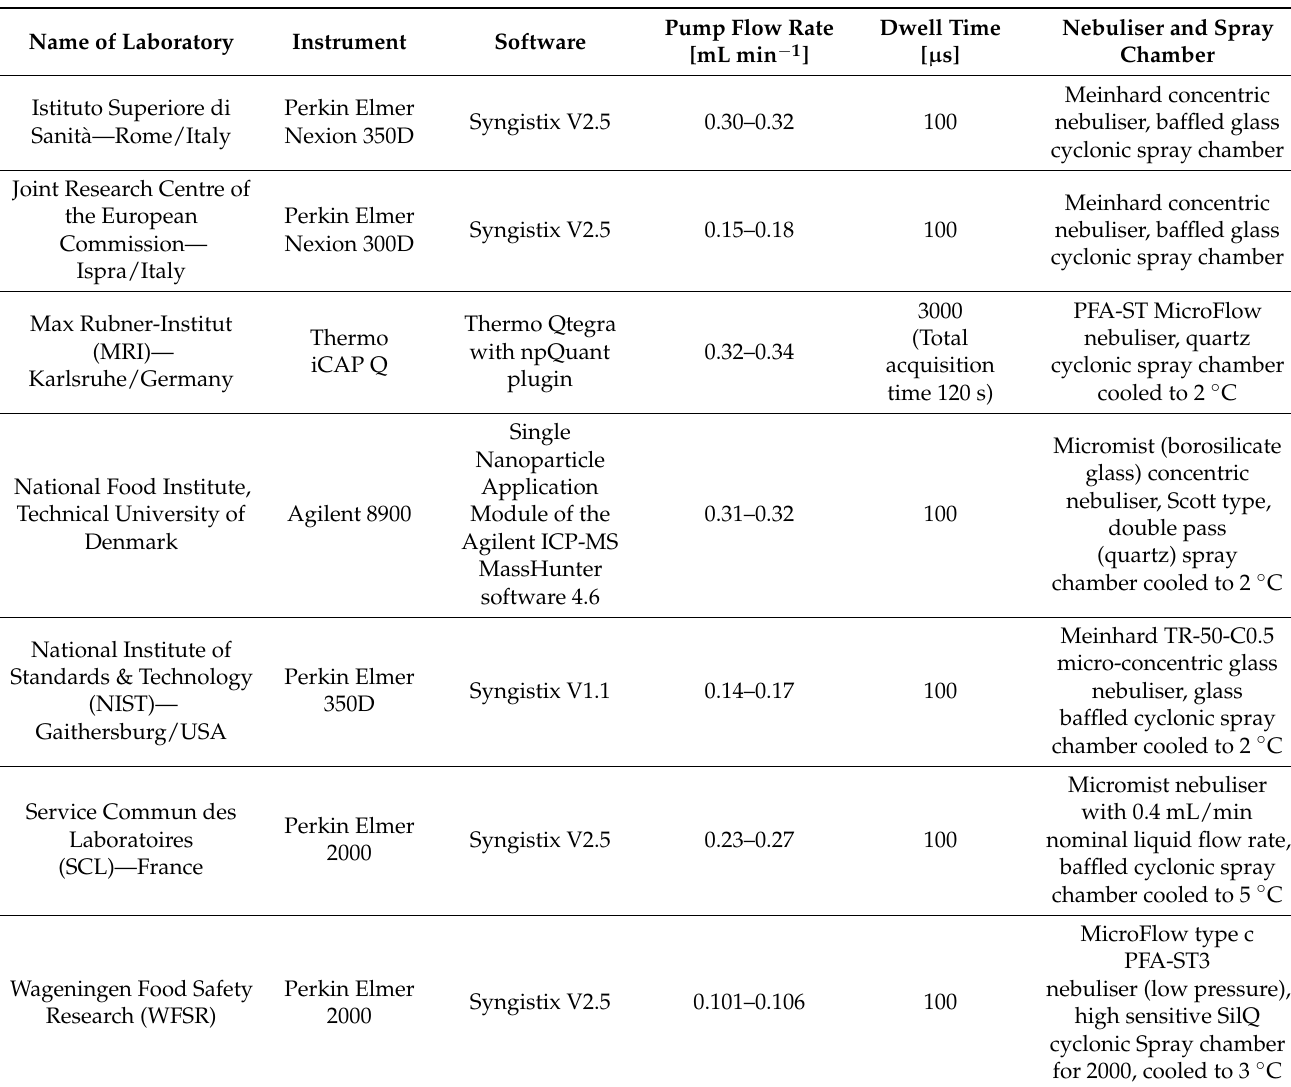
Table 3. Participants, instruments, instrumental settings and software